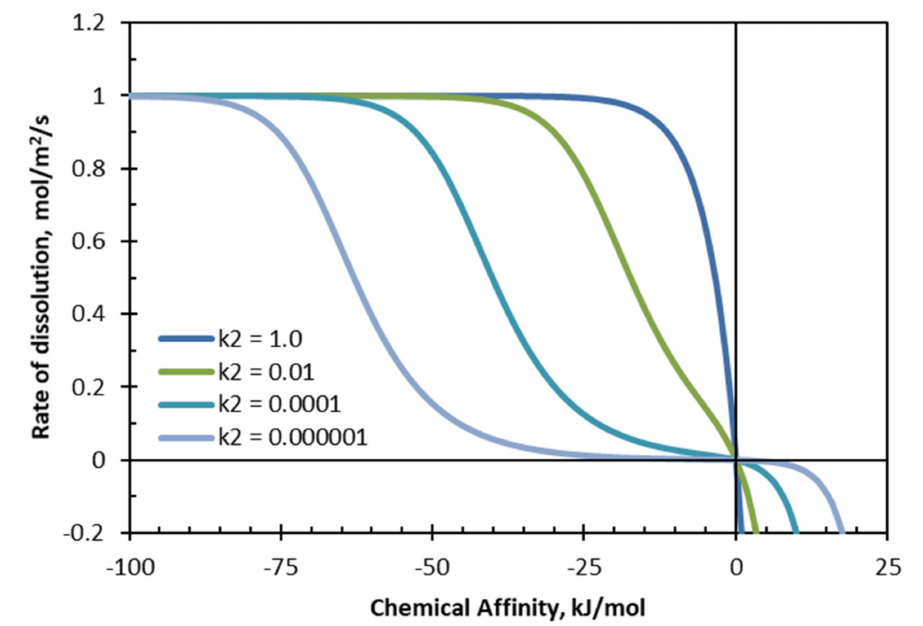
Figure 11. The rate of dissolution as a function of the chemical affinity for different values of the parameter k 2 in Equation (24). The legend gives the values of k 2 used. The other parameters have the following values: K = 1, k 1 = 1, t = 0. For further details, refer to Crundwell